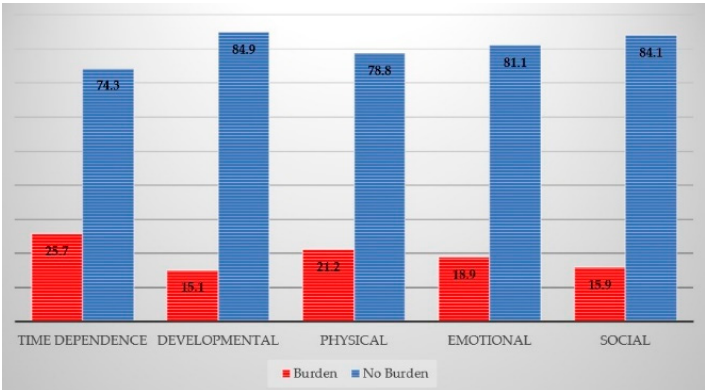
Figure 2. The distribution of family caregiver burden over the five domains considered in the Caregiver Burden Inventory, Maehia subdistrict, Chiang Mai, Thailand, 2019.